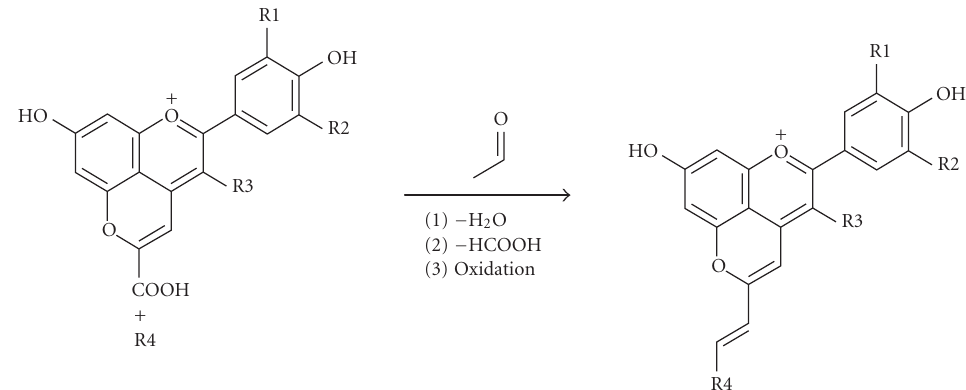
Figure 5. Formation reaction of portisins. R 1 and R 2 are H, OH, or OMe, R 3 is an (-O-glycosyl) group which is substituted with one, or more acyl groups, and R 4 is an aryl.